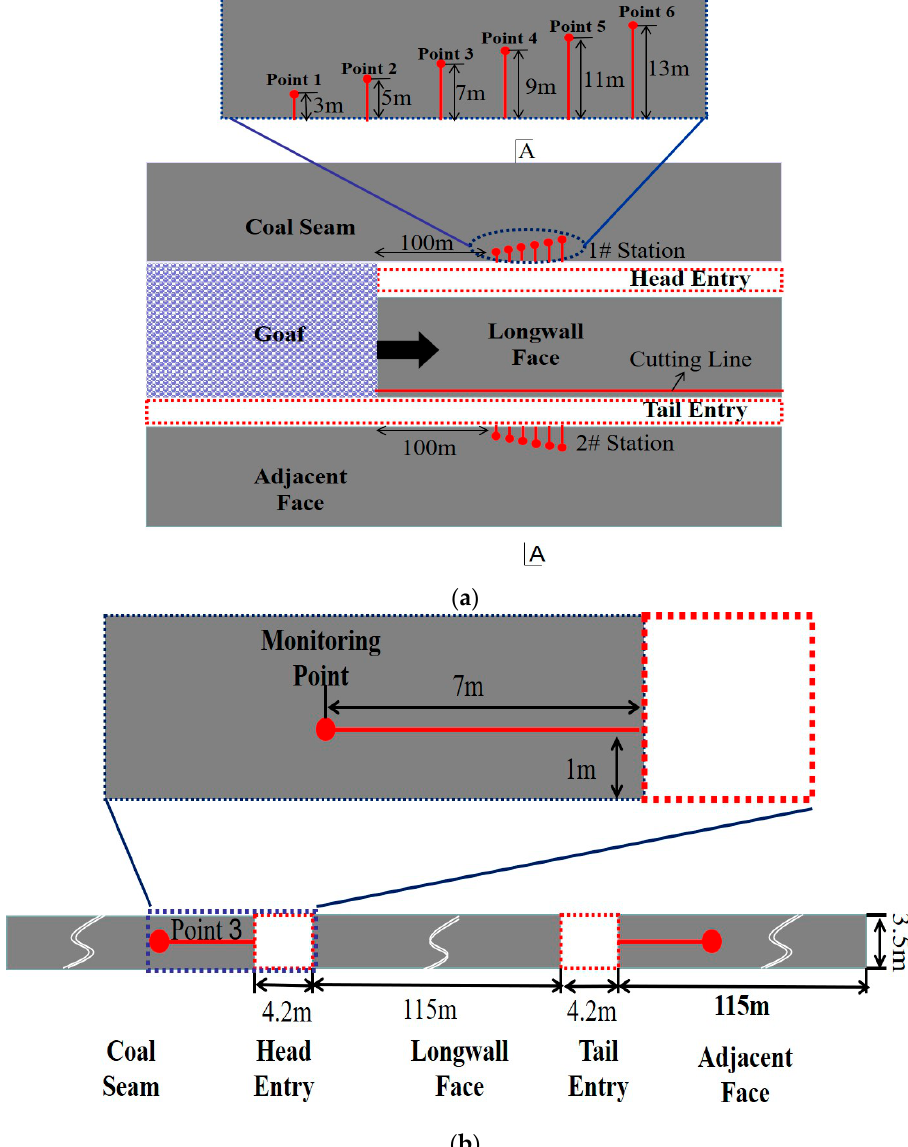
Figure 10. The test site and position of the FDU: ( a ) Longwall panel layout and the test site of the FDU. ( b ) A-A cross section in Figure 10a.